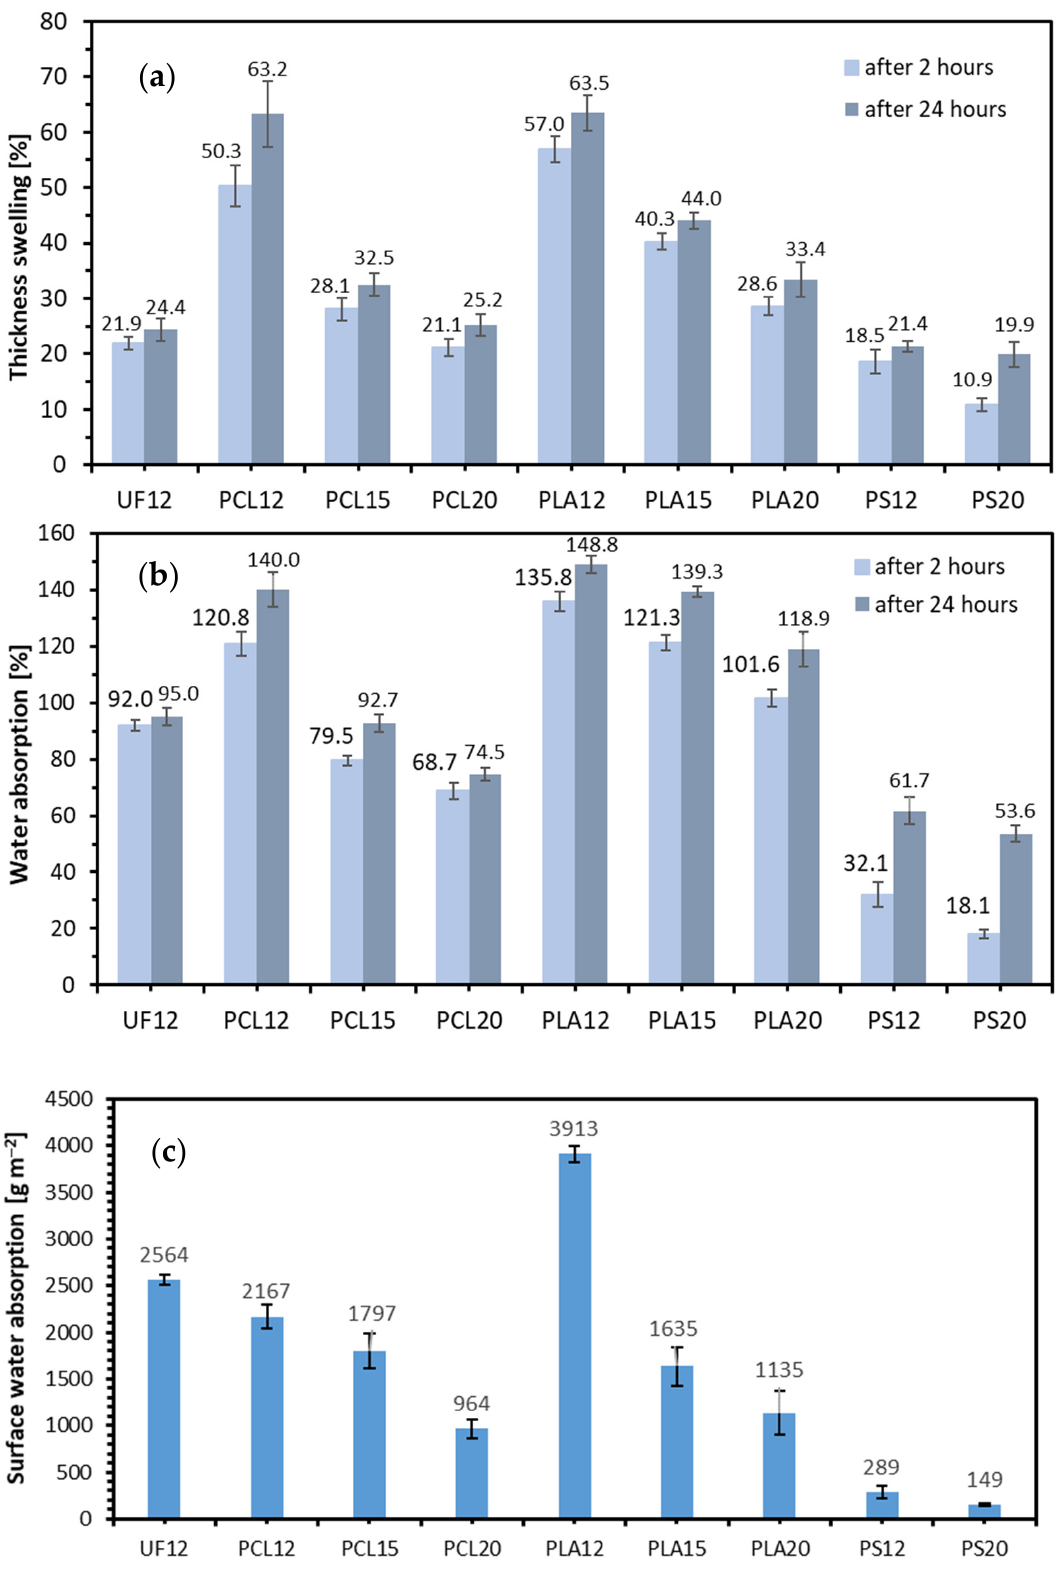
Figure 7. ( a ) Thickness swelling, ( b ) water absorption, and ( c ) surface water absorption of tested lignocellulosic composites.